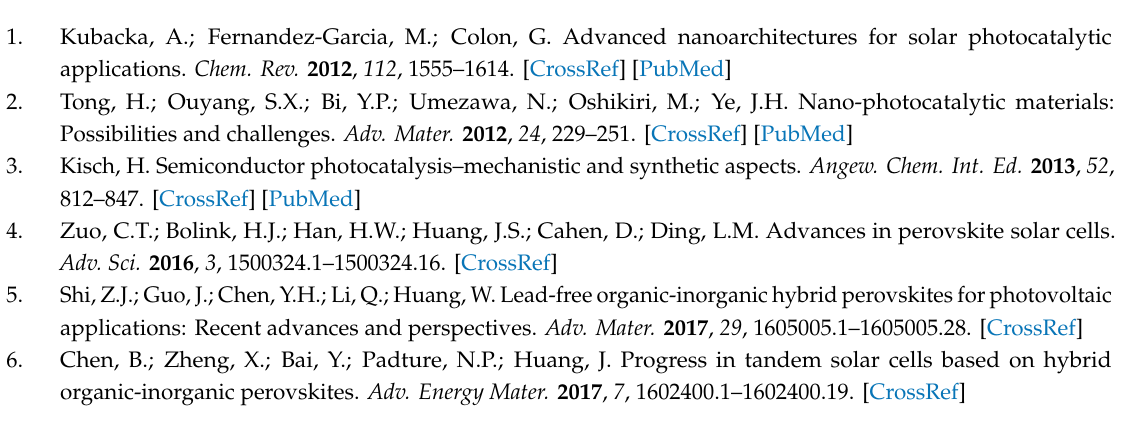
Figure S1: UV–vis absorption spectra curves of MB solution irradiated under UV, visible and NIR light, Figure S2: XRD patterns of NaBiS 2 before and after photocatalytic